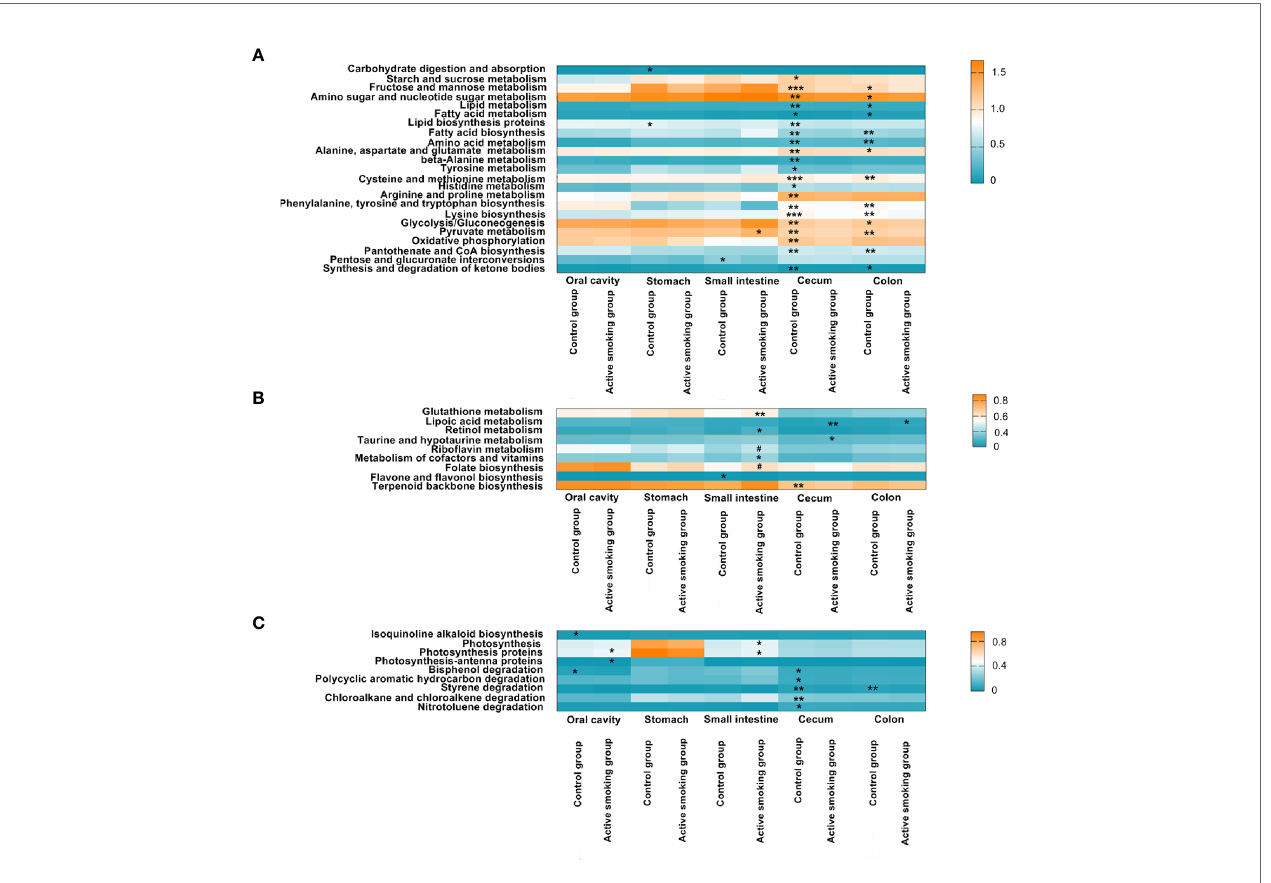
FIGURE 10 | Associations between active smoking status and inferred bacterial functions. Bacterial KEGG pathways signi fi cantly enriched in the control group or active smoking group were plotted as heatmaps by region along the digestive tract. Regions of the digestive tract and active smoking status are indicated at the bottom. Each bar represents the median relative abundance of a certain functional KEGG pathway of samples from each digestive tract region. The colors denote the variation in median relative abundance. Blue denotes the lowest abundance, while orange represents the highest abundance. The transition between high and low relative abundance is expressed in white. (A) Metabolism or biosynthesis of the primary nutrition substance-related pathways. (B) Metabolism or biosynthesis of antioxidant- and vitamin-associated pathways. (C) Diabetes-improving chemical biosynthesis-, photosynthesis-, and xenobiotic degradation-related pathways. # denotes p -value = 0.05 and *, ** and *** denote p -value < 0.05, p -value < 0.01 and p -value < 0.001 versus the control group or active smoking group,